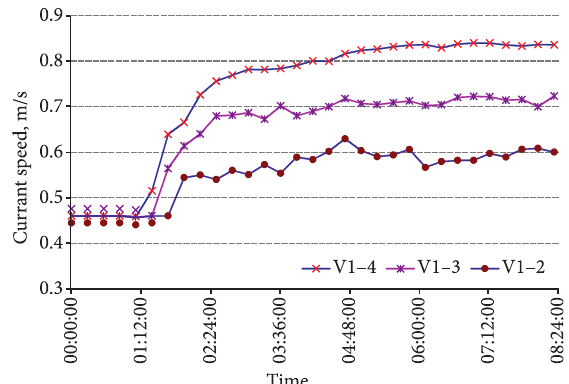
Fig. 9. Changes in the flow velocities V 0 at the second abutment of Railway Bridge due to the increase in the number of operating turbines from 1 to 2 (V1–2), from 1 to 3 (V1–3) and from 1 to 4 (V1–4)